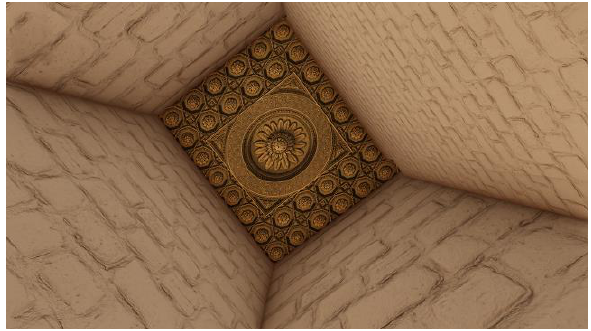
Figure 10. Celing decoration of the south adyton